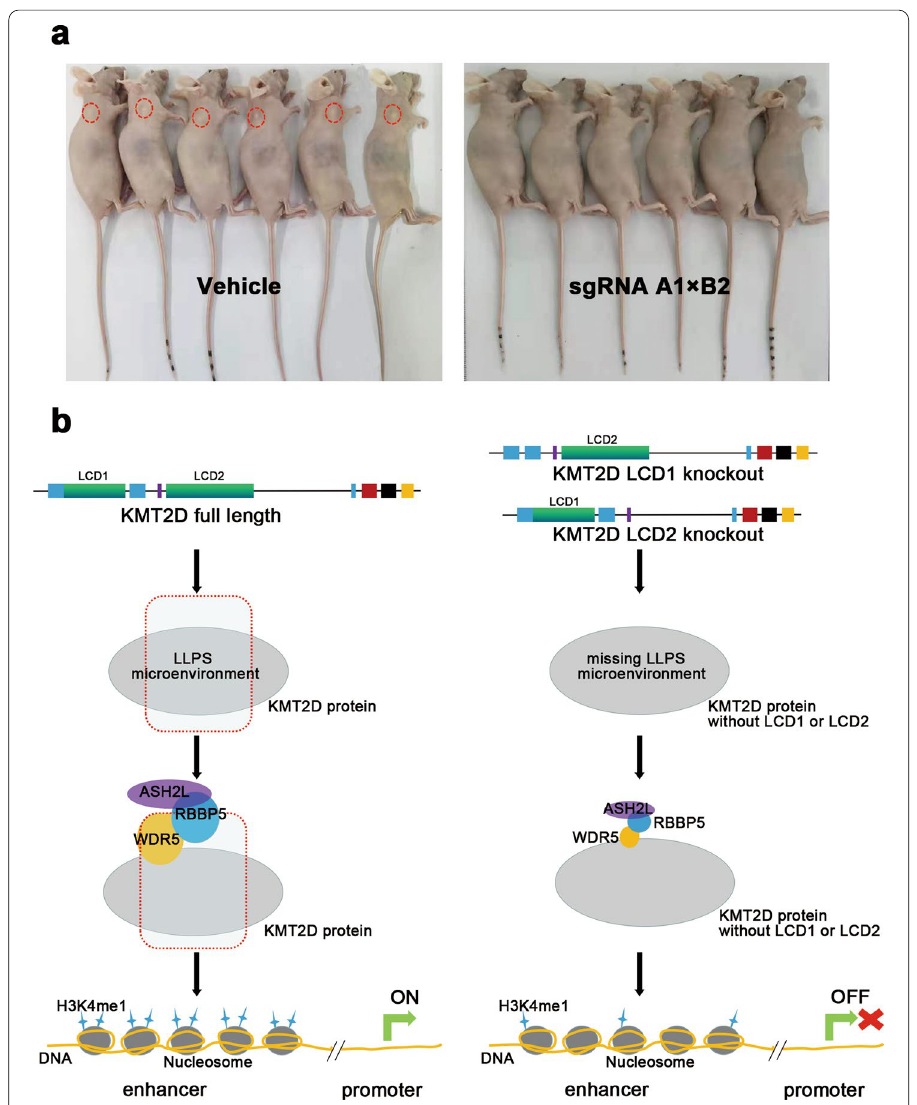
Fig. 7 a Nude mice bearing established PANC1 xenograft tumors, including the vehicle group and sgRNA A1 B2 group. After 2 weeks, tumor formation was monitored for a further 3 weeks. Interestingly, we could × not detect tumor formation for PANC1 cells modified with LCD1 knockout, while the vehicle group could form tumors (red circle). b The proposed mechanistic model of for KMT2D LCDs in gene transcription. The knockout of KMT2D LCDs results in a loss of ability to form a stable LLPS microenvironment. The stability of WDR5 protein significantly decreased, and the protein–protein interactions between the components involved in the KMT2D–enzyme complex were attenuated. Some transcription factors, such as LIFR and KLF4, were markedly downregulated, attributed to the decrease in the H3K4me1 level. The left panel indicates the mechanism for full-length KMT2D, while the right panel indicates the mechanism for knocked out KMT2D